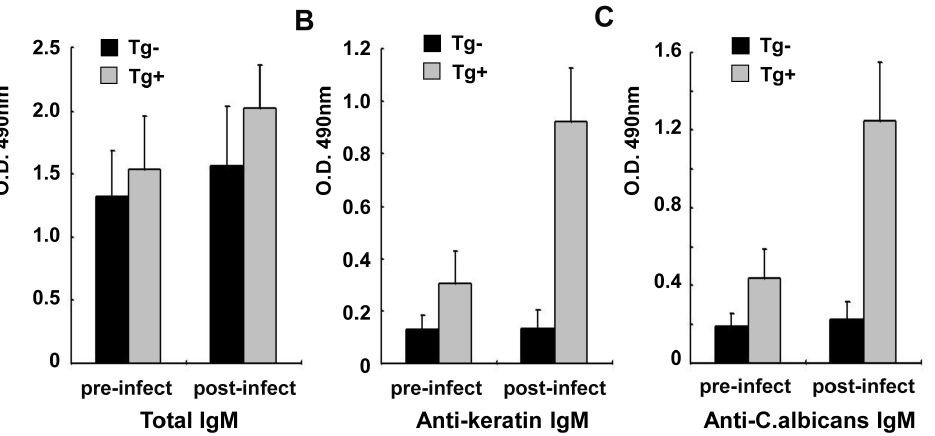
Figure 2. Natural IgM production in PEC. PEC lavage before and after C. albicans inoculation were detected by ELISA using plate coated with anti-mouse IgM antibody or live C. albicans . (A) Total IgM, (B) C.albicans -specific IgM. Data shown are means 6 SD, n=6. * P ,